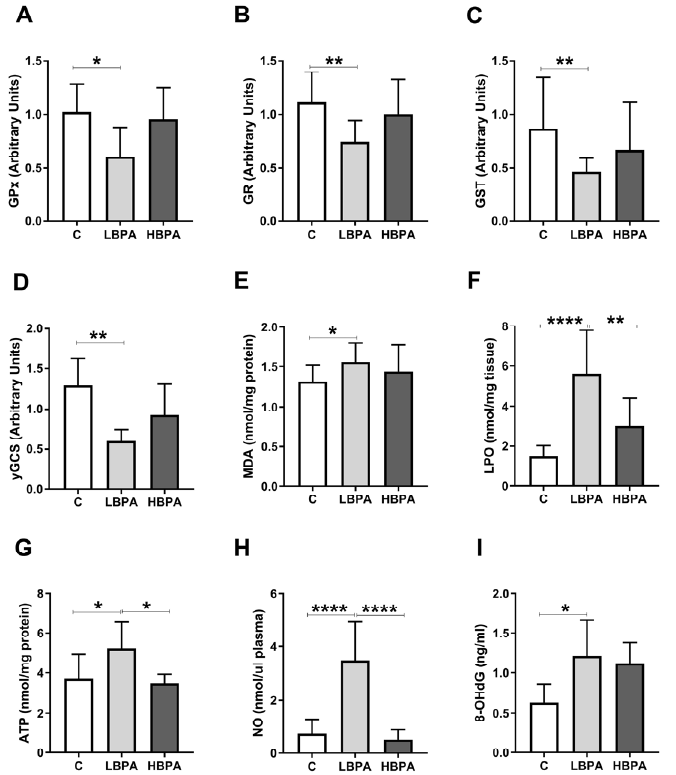
Figure 3. Gene expression profile of GSH-related enzymes and parameters of oxidative damage in livers from lactating dams after exposure to different doses of BPA. ( A ) Glutathione peroxidase (GPx), ( B ) glutathione reductase (GR), ( C ) glutathione S-transferase (GST) and ( D ) γ -glutamylcysteine synthetase ( γ -GCS) relative gene expression. ( E ) Malondialdehyde (MDA) content in nmol/mg protein. ( F ) Lipid hydroperoxide (LPO) content in nmol/mg tissue. ( G ) Adenosine triphosphate (ATP) levels in nmol/mg protein. ( H ) Concentration of nitric oxide metabolites (NO) in nmol/ µ L plasma. ( I ) Concentration of 8-oxo-2 (cid:48) -deoxyguanosine (8-OHdG) in ng/mL. Data represent mean ± SD. For mRNA, n = 8 control dams; n = 8 LBPA dams; n = 6 HBPA dams (three replicates for each gene). For ELISA assay, n = 8 control dams; n = 8 LBPA mg/kg dams; n = 6 HBPA dams (two replicates for each sample). Statistical significance was determined by one-way ANOVA. * p < 0.05; ** p < 0.01; **** p <